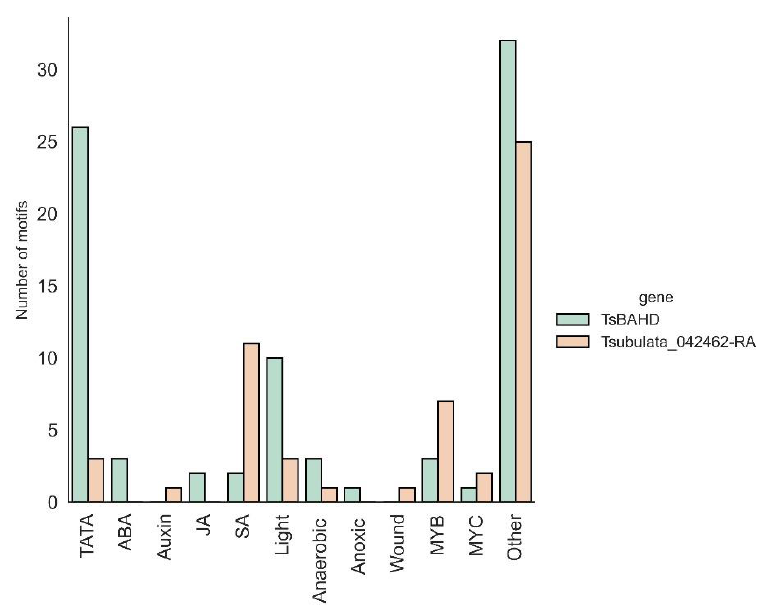
Figure 9. Cis -regulatory element motifs identified in the promoter region of TsBAHD and its closest paralog Tsubulata_042462-RA. paralog